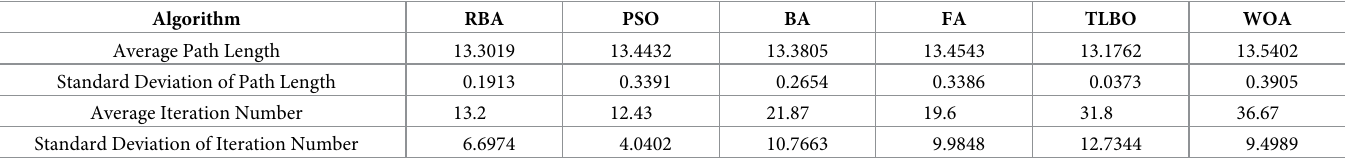
Table 1. Performance comparison between RBA and classical optimization algorithms in test case 1.